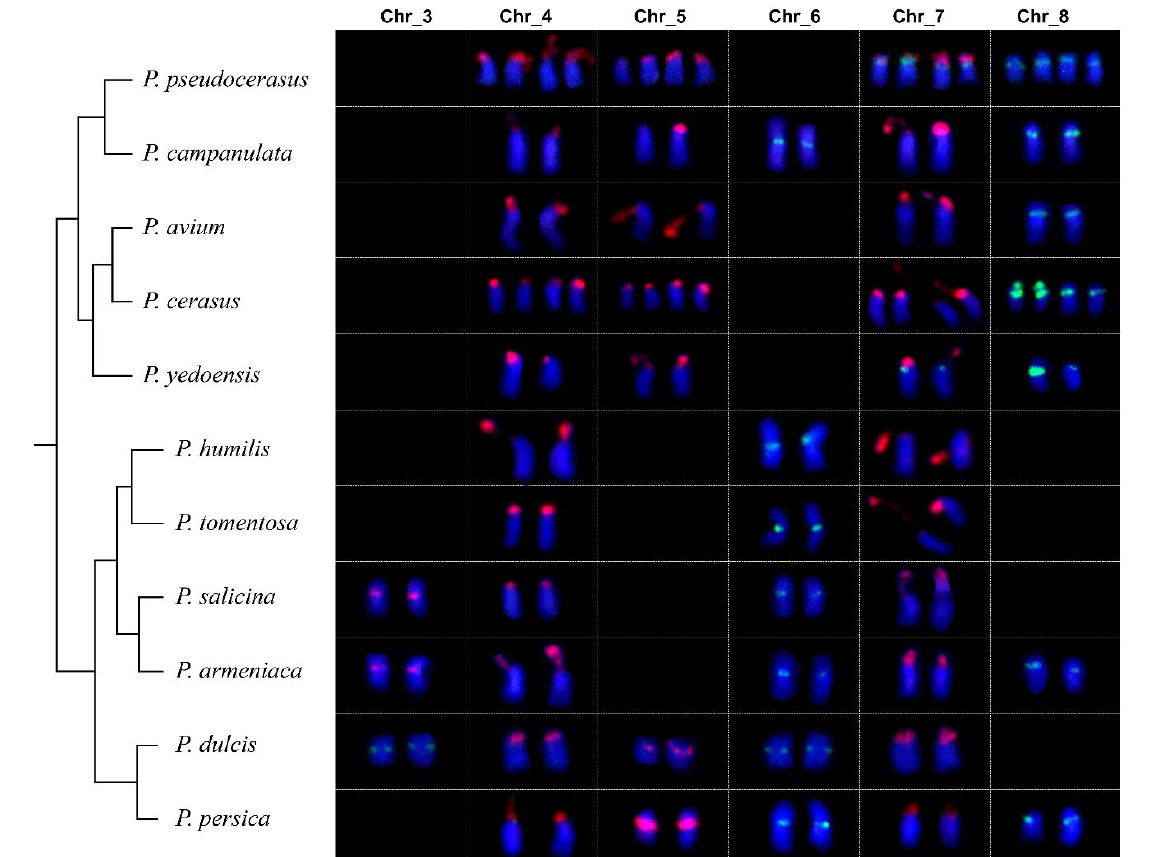
Figure 7. Variation in the distribution of 5S rDNA (green) and 45S rDNA (red) among Prunus . The phylogeny of the eleven species in this study was constructed based on 45S rDNA.